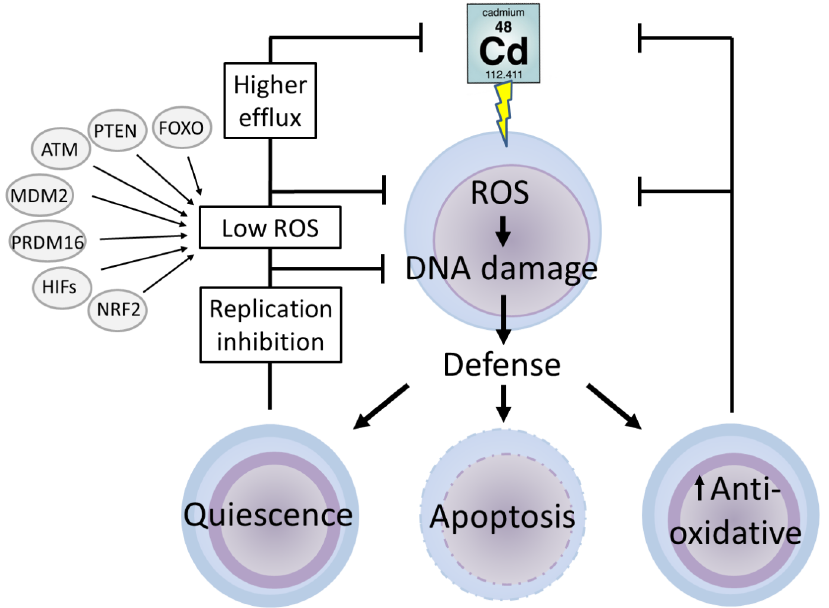
Figure 3. Schematic overview of Cd toxicity in stem cells in general. Intoxication of stem cells by Cd could indirectly induce oxidative stress by impairment of the redox